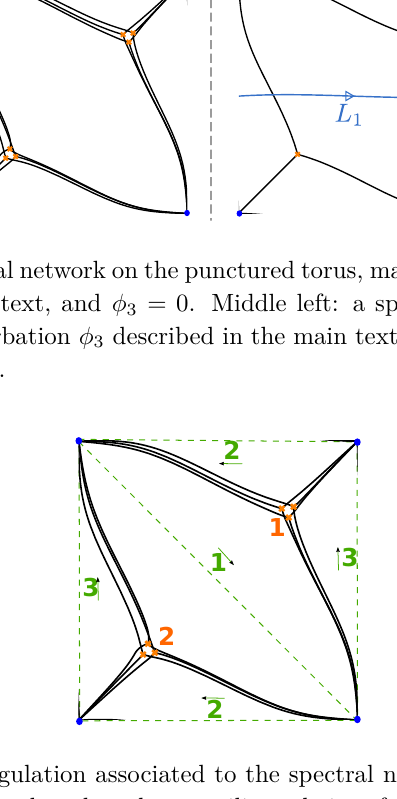
Figure 46 . The WKB triangulation associated to the spectral networks shown in figure 45, with the 3 edges and 2 triangles numbered, and an auxiliary choice of orientation fixed on each